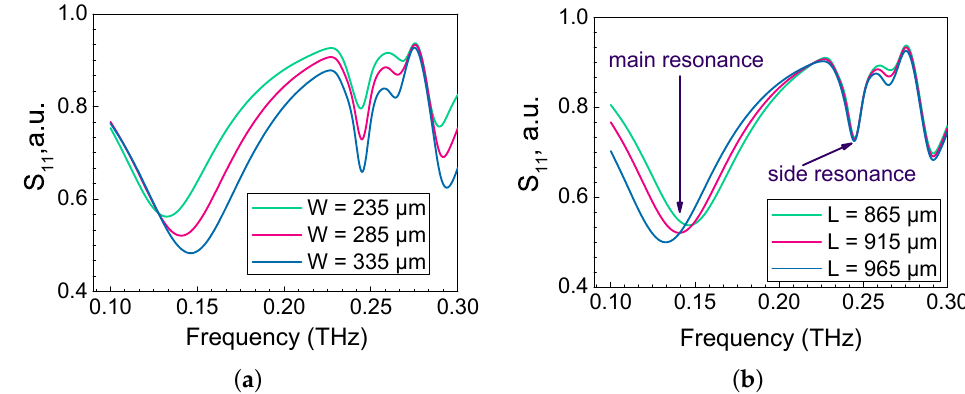
Figure 3. The example of reflection amplitude spectrum adjustment for Bi 88 Sb 12 films on a polyimide substrate. ( a ) the impact of cross width (W) change (cross length = 915 µm and period = 1267 µm) ( b ) the impact of cross length (L) change (cross width = 285 µm and period = 1267 µm).